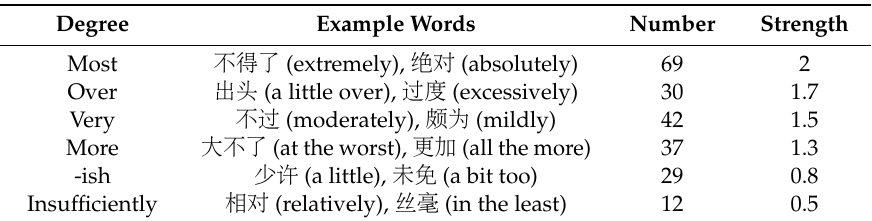
Table 1. Degree adverb word and